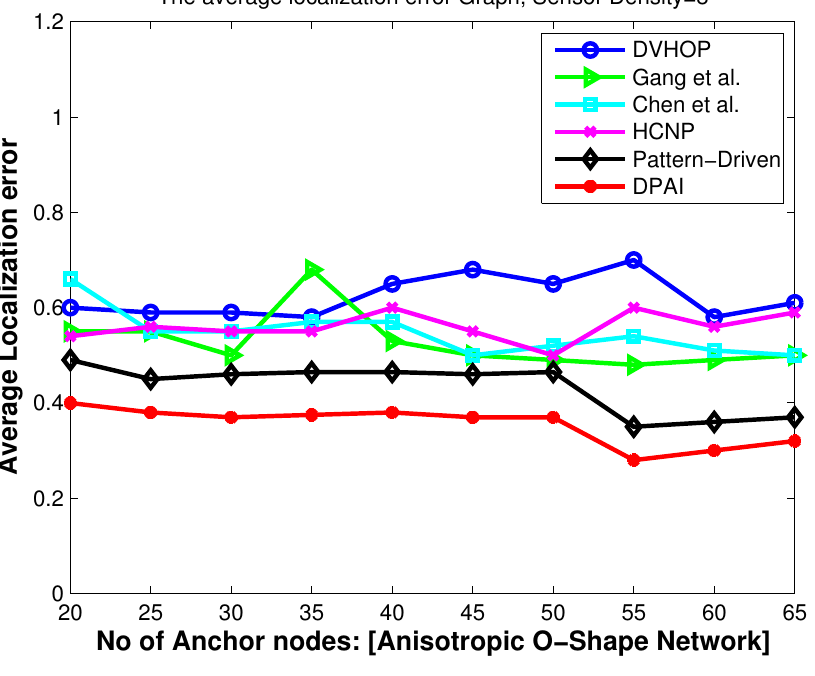
Figure 6. Location error vs . number of anchor nodes.(O-shape network).